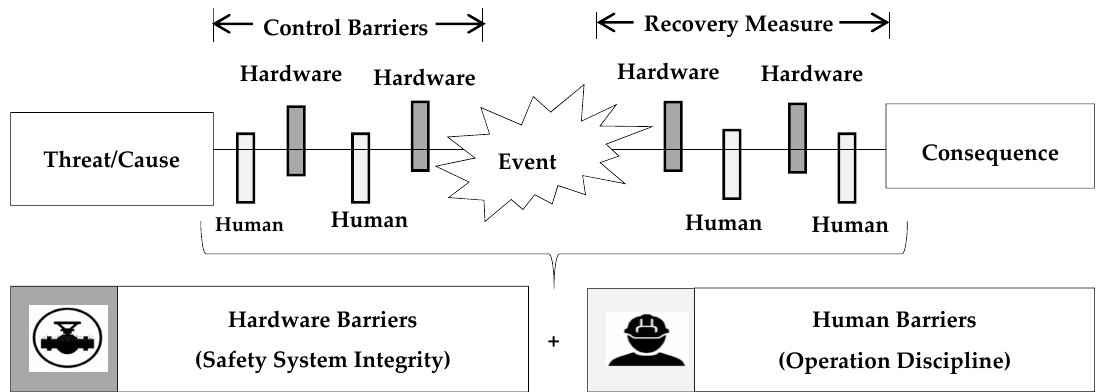
Figure 14. Generic arrangement of control barriers and recovery measures in the O&G industry (Adapted from IOGP [35]).